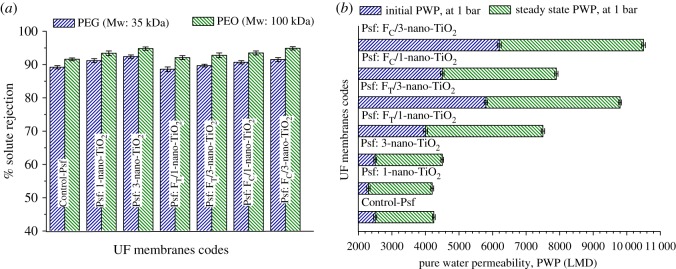
Macroscopical features, (a) % SR and (b) PWP of membranes: Control-Psf UF, Psf: nano-TiO2 UF, Psf: FT-nano-TiO2 UF and Psf: FC-nano-TiO2 UF.